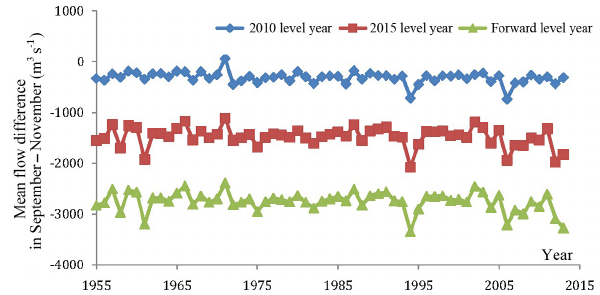
Figure 6. Process of Yichang hydrological station from September to November in normal year (1969).